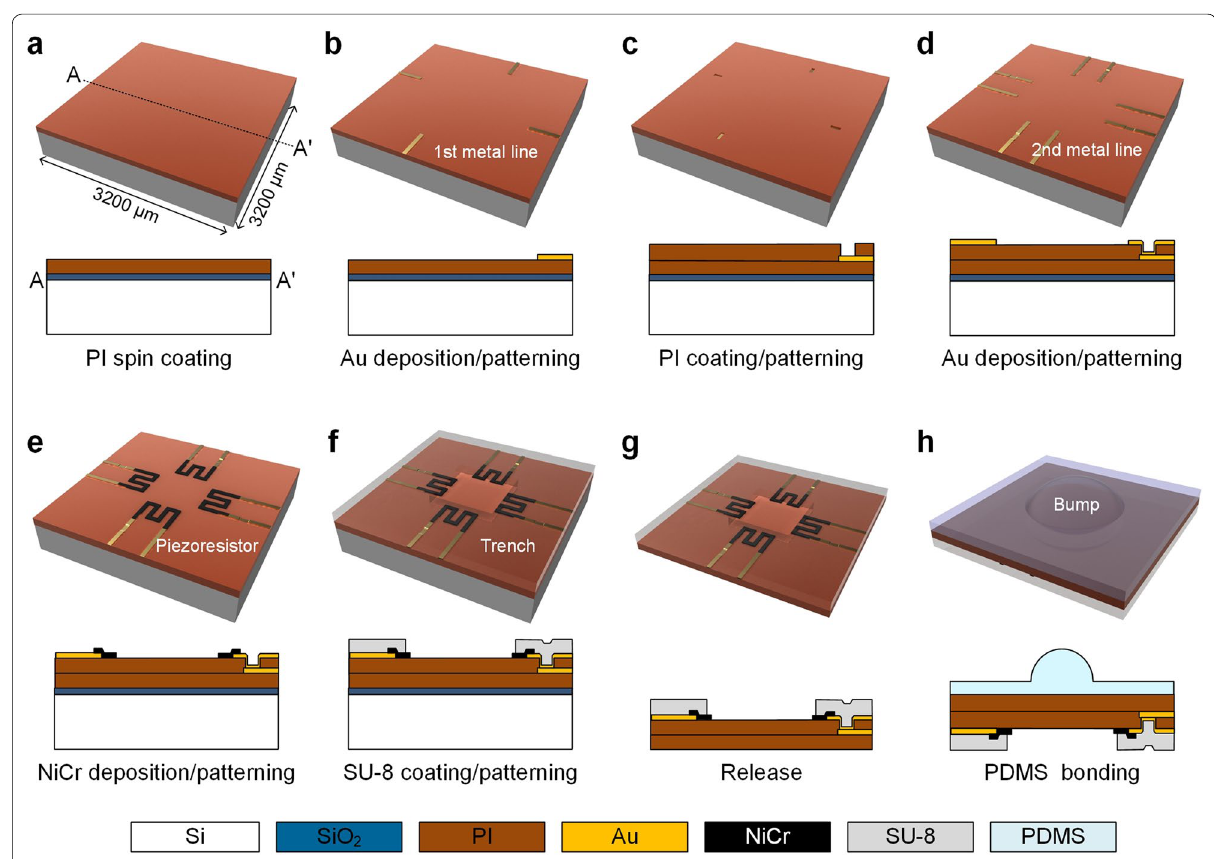
Fig. 3 Fabrication process flow of the polymer‑based flexible and multi‑directional tactile sensor. NiCr piezoresistors and double‑layered metal lines are patterned via conventional microfabrication, including photolithography, evaporation, sputtering, plasma etching, and a lift‑off process. Then, the PI film with sensor components is detached from the wafer. Finally, the PDMS bump that is fabricated separately is assembled with the main